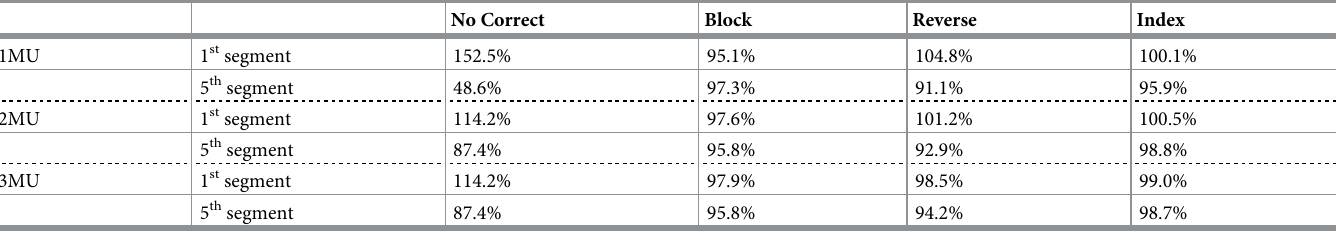
Table 3. Relative doses at the first and last segments in relation to the overshoot effect after the three corrections were applied. No Correct Block